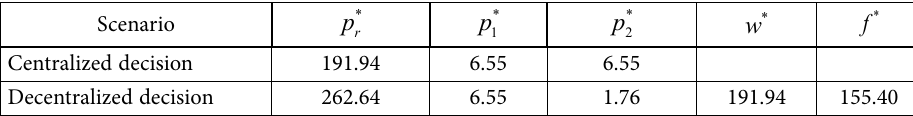
Table 4. Optimal expected profits of entire system and each individual firm